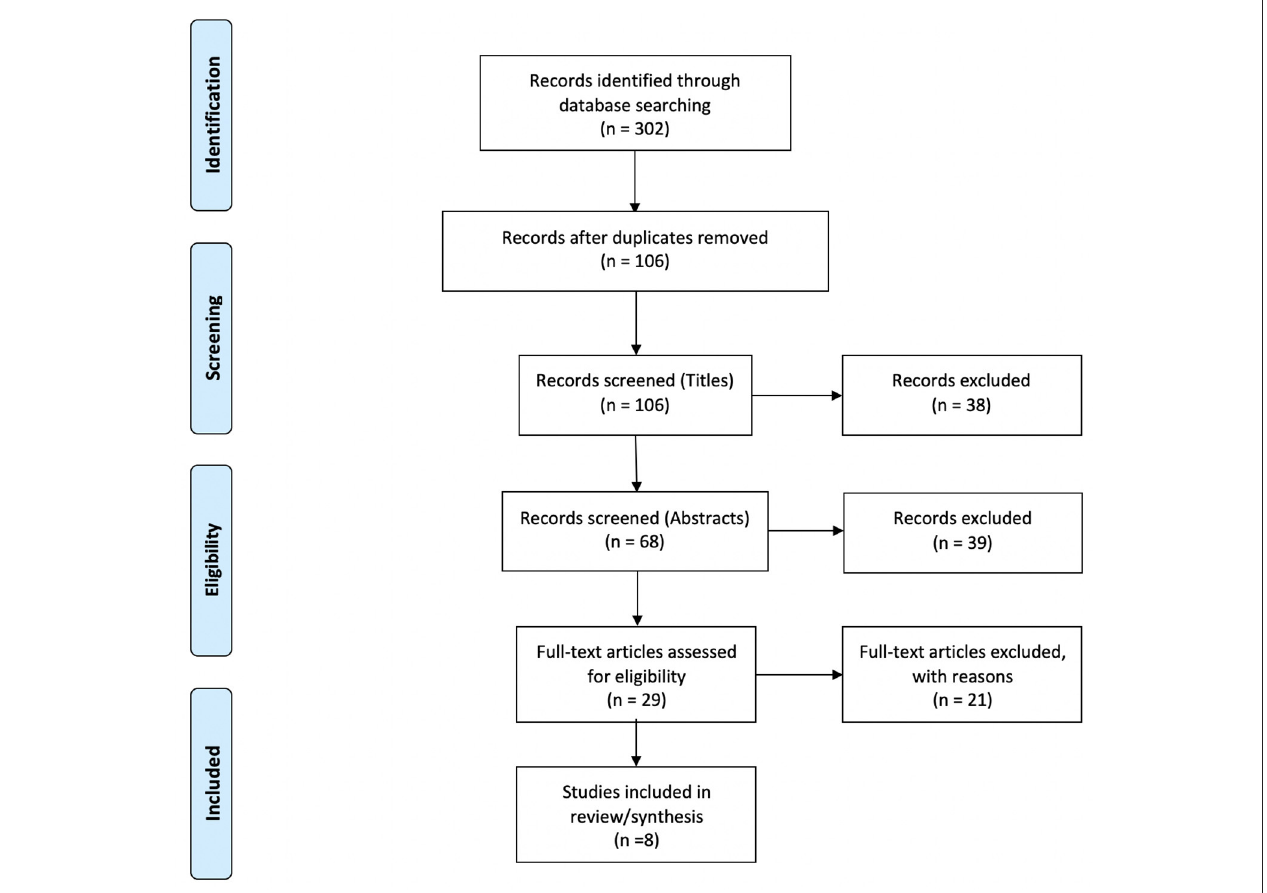
FIGURE 1 | PRISMA flow